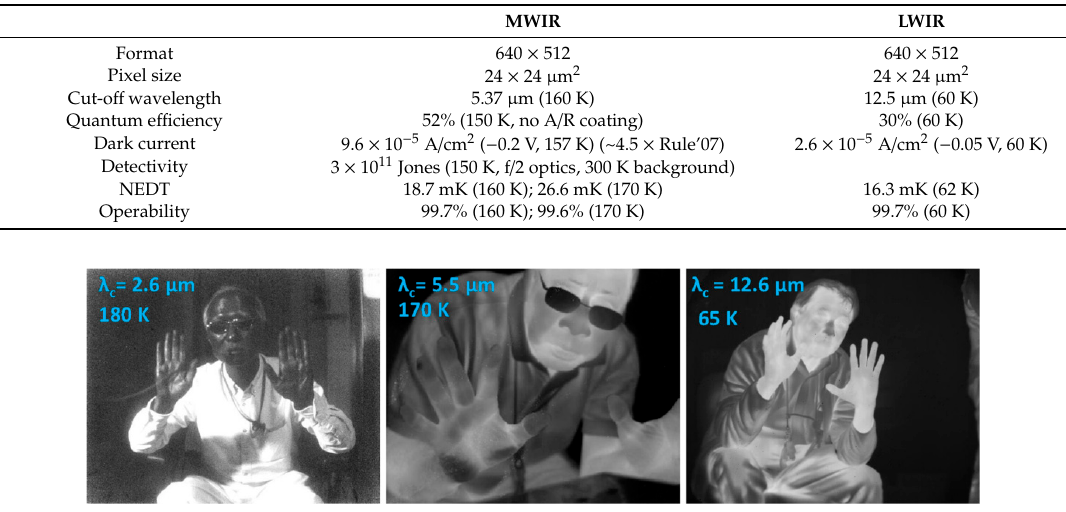
Table 7. Performance of InAs / InAsSb T2SLs nBn detector FPAs ([172,211]).